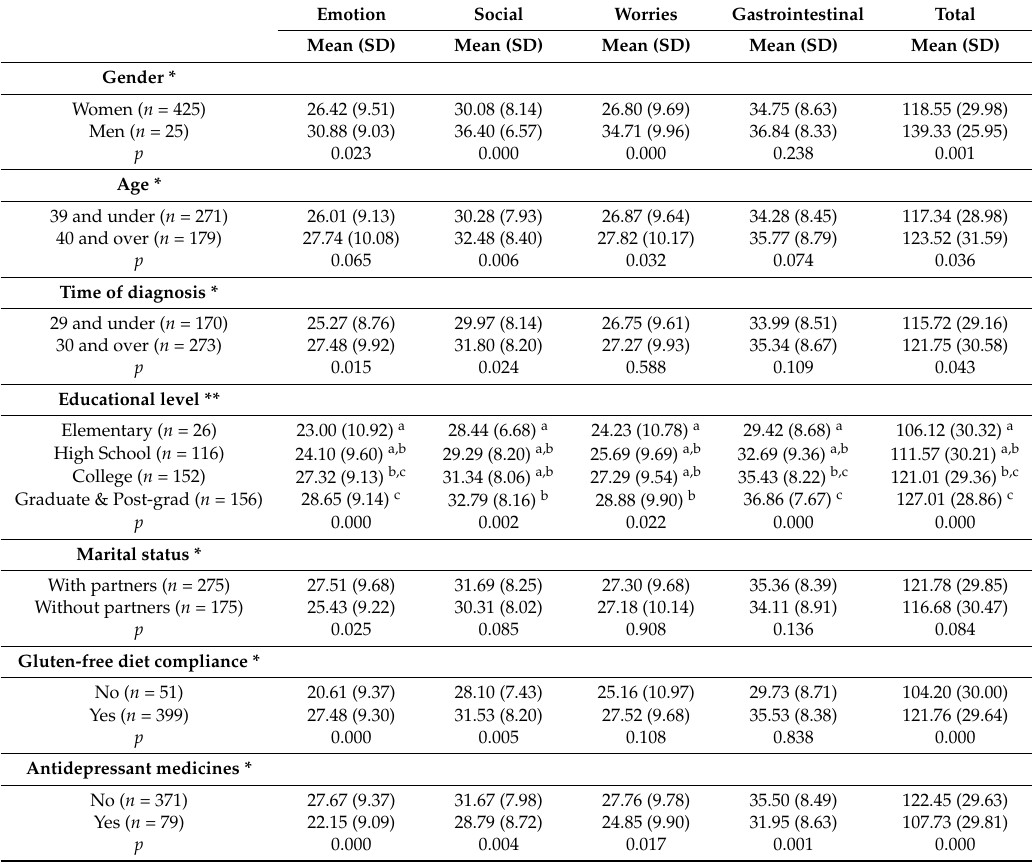
Table 3. Sub-scores of the CD-QoL scale subcategorized by sex, age, time of diagnosis, schooling, marital status and